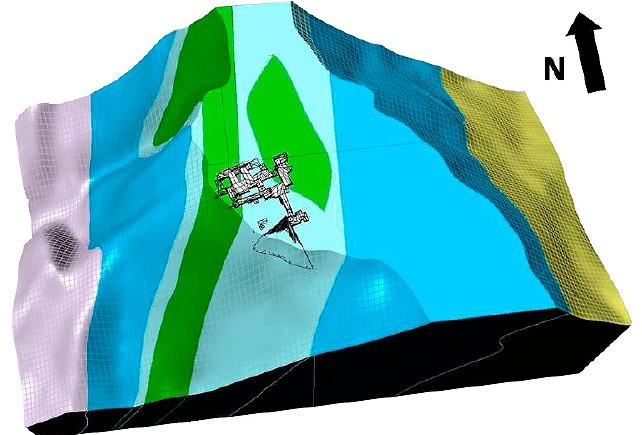
Figure 4. Perspective view of the 3D geological model. Colors of the geological formations